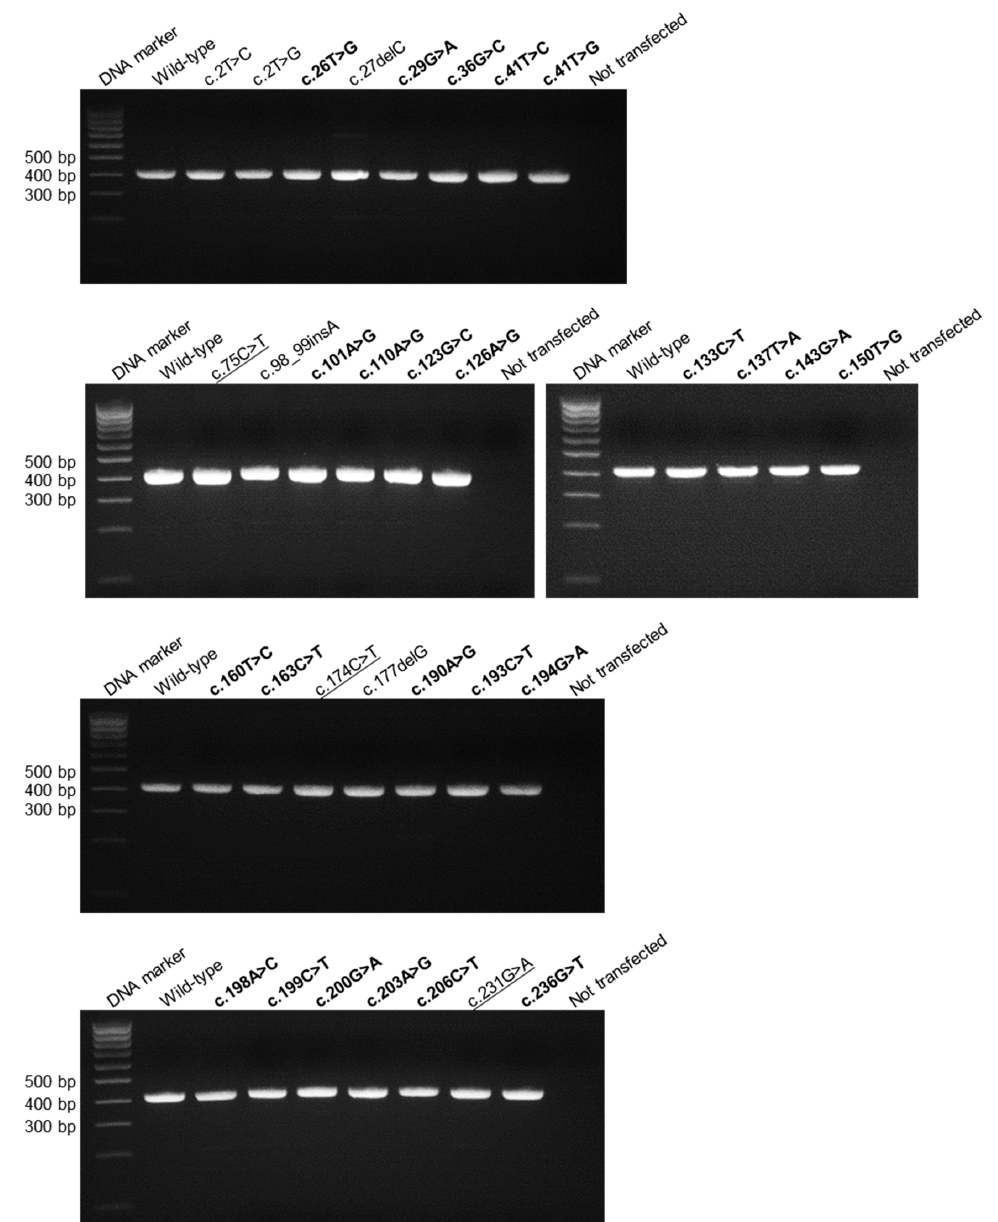
Figure 1. Qualitative RT-PCR analyses of HEK293T cells transfected with the full-length gene expression constructs carrying various SPINK1 exonic variants. The missense and synonymous variants under study (Table 1) are highlighted in bold and underlining, respectively. The remaining variants, all of which are clearly loss-of-function variants (i.e., translational initiation codon or frameshifting variants), were not discussed in this study. Note that the previously studied c.194G>A variant [4] was also included for the reason of